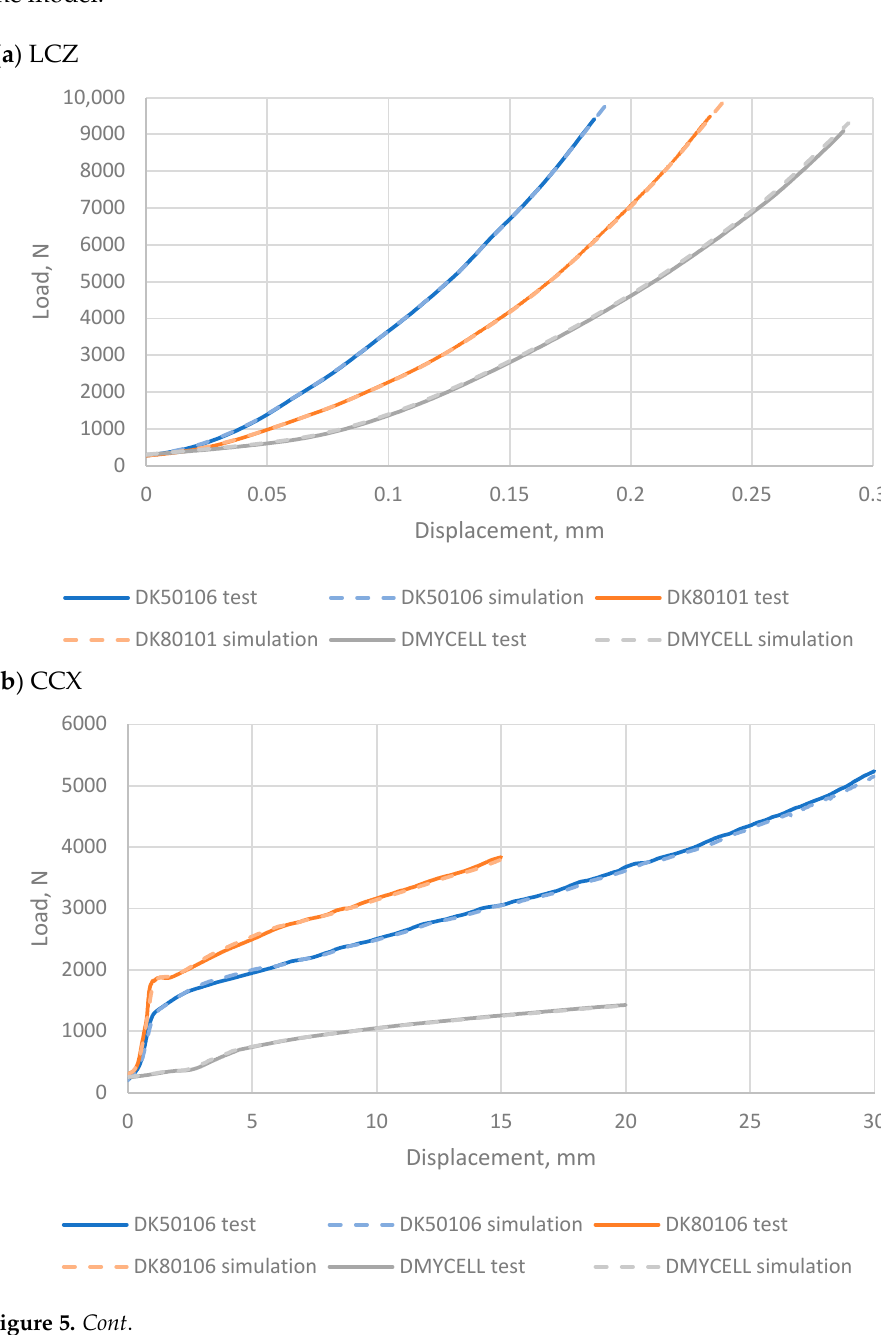
Figure 4. Typical load displacement curves from Dow Kokam SLPB5010600 pouch; ( a ) Lateral compression in Z ( b ) Confined compression in X, ( c ) Confined compression in Y (Insets—de ‐ formed cell and CT scan section of folds), ( d ) 3 ‐ point bend around X axis, ( e ) 3 ‐ point bend around Y axis (Inset deformed cell). All tests conducted at 50% SoC.